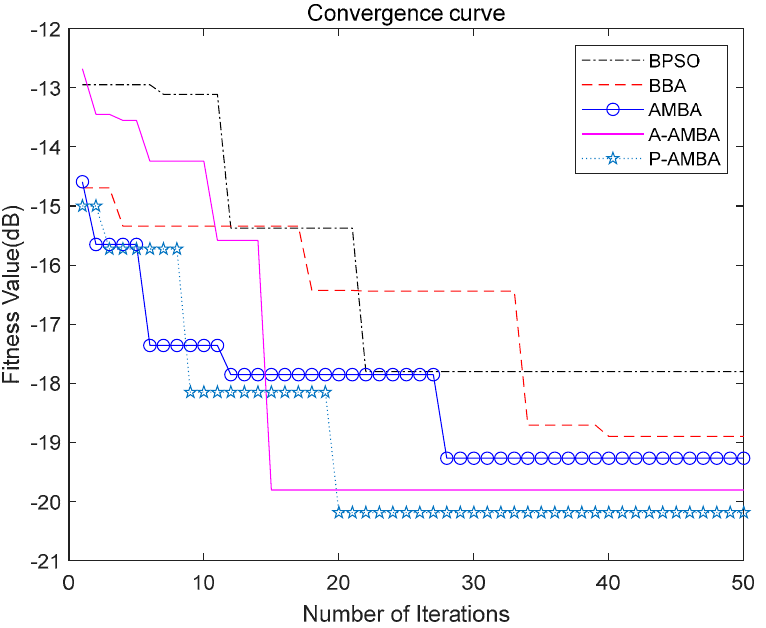
Figure 9. Comparison of the convergence curves of BPSO, BBA, AMBA, A-AMBA, and P-AMBA. The antenna topology design is different from the traditional antenna structure